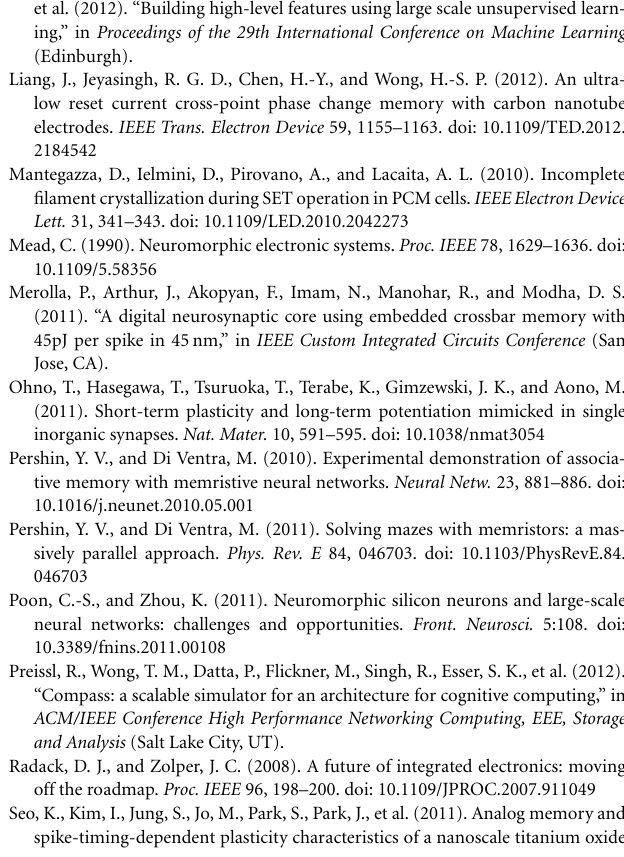
Supplementary Figure 1 | Measurement setup used in experiments. Probe card that directly probes pads on memory chip are connected to switch matrix. Setup is controlled by computer